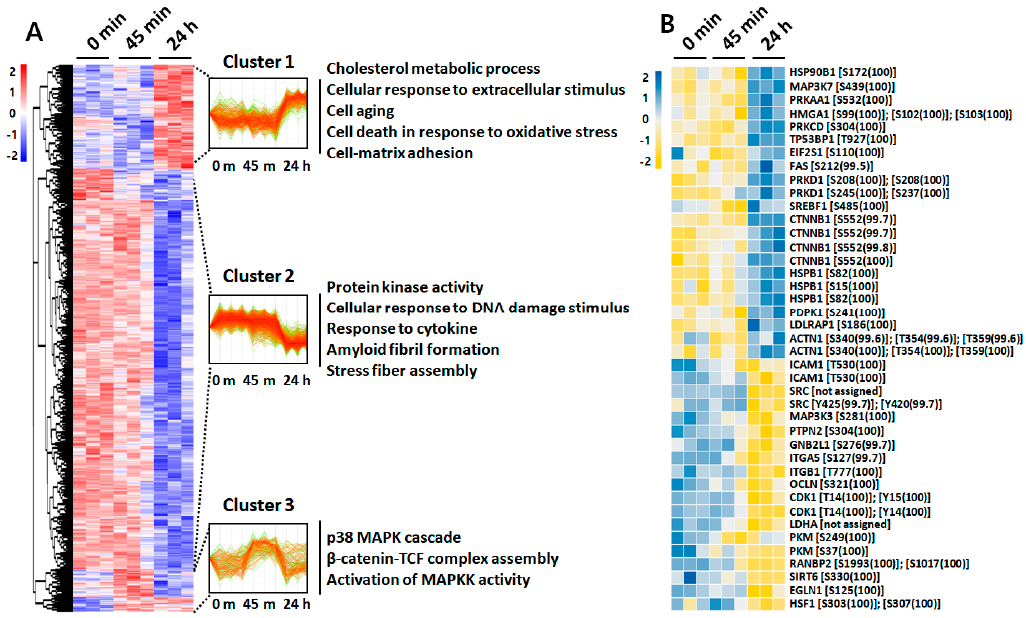
Figure 4. HCL analysis of the identified phosphoproteins with differential phosphorylation